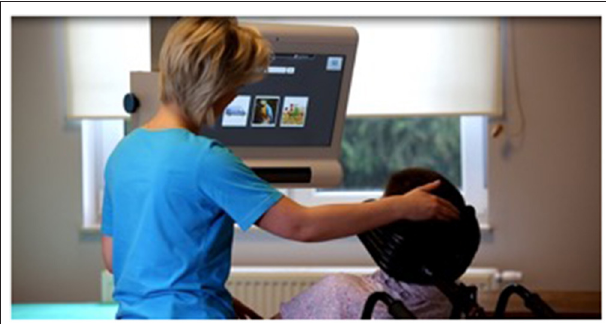
Characteristics